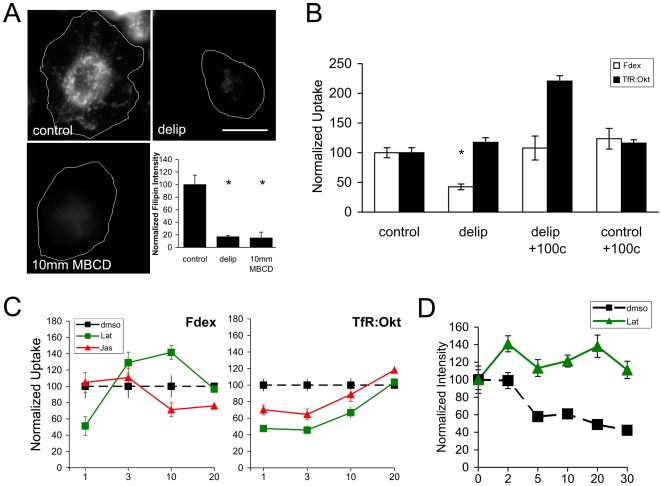
Role of actin and cholesterol in S2R+ endocytic pathways.(A) Panels shows fluorescent micrographs of filipin staining in: untreated S2R+ cells (control); cells adapted to growth in delipidated, cholesterol-free medium (delip; see Materials and Methods); and control cells treated with 10 mM MβCD for 30 min. Bar graph shows quantification of the total filipin intensity across the different treatments (mean±s.e.m., >90 cells for each treatment from 2 experiments; asterix denote P<0.05 by Student's t-test). (B) Normalized Fdex and TfR uptake in: control S2R+ cell line, cholesterol-free adapted line (delip), cholesterol-depleted lines repleted with 100 µg/ml cholesterol for 12 hrs (delip+100c) and control line grown in 100 µg/ml cholesterol for 12 hrs (control+100c). Mean±s.e.m. values are derived from 2 independent experiments with n>200 cells in each condition. Asterixs denote P<0.05 by Student's t-test. (C) Normalized uptake of Fdex and TfR in S2R+ cells over different pulse times (in minutes) in medium containing either carrier dimethyl sulphoxide (dmso); 1 µM Latrunculin A (Lat) or 4 µM Jasplakinolide (Jas). Values are represented as mean±s.e.m. at each time point/treatment, >200 cells per treatment in 2 independent experiments. (D) S2R+ cells were prepulsed for 2 hrs with Fdex and then chased in medium without probe either with Latrunculin A (Lat) or carrier alone (dmso) for increasing lengths of time in minutes. At the end of each chase time, cells were fixed and the total remaining cell-associated Fdex intensity was quantitated and normalized to control levels. Each point on the graph is represents mean±s.e.m. from 2 independent experiments with at least 100 cells each. Bar in A = 5 µm.